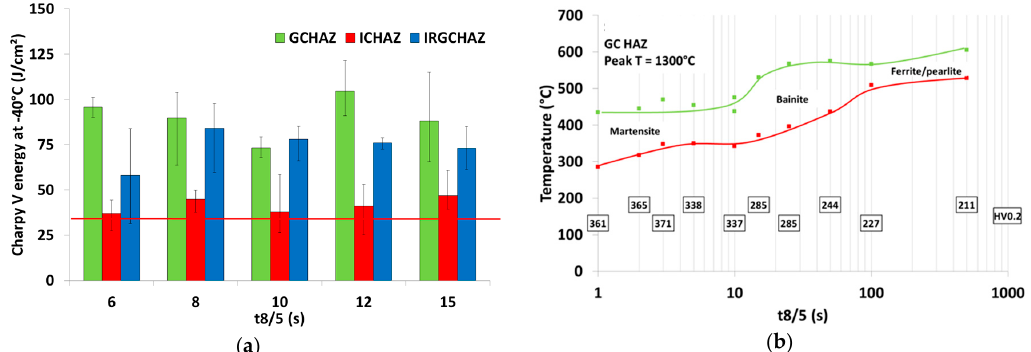
Figure 9. Welding simulation data for DQ3 steel: ( a ) Charpy V impact energy at − 40 °C on Gleeble annealed samples with different t 8/5 (GC HAZ: peak temperature 1350 °C, ICHAZ: peak temperature 775 °C, IRGZ HAZ: dual cycle: T p1 = 1350 °C; T p2 = 775 °C), ( b ) Welding CCT diagram for the CG HAZ (Thermal cycle: Heating at 100 °C/s up to 800 °C, then 300 °C/s to peak temperature 1300 °C, followed by cooling using different cooling times between 800 and 500 °C ( t 8/5)).